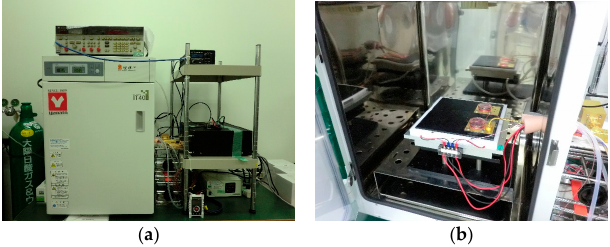
Figure 1. ( a ) The built-in incubator of the 0.12 THz exposure system, and ( b ) an inside view of the incubator. The cavity in the exposure system was maintained under controlled conditions similar to those in an incubator—i.e., an atmosphere of 95% air and 5% CO 2 at a relative humidity of >95% and a temperature of 37 ˝